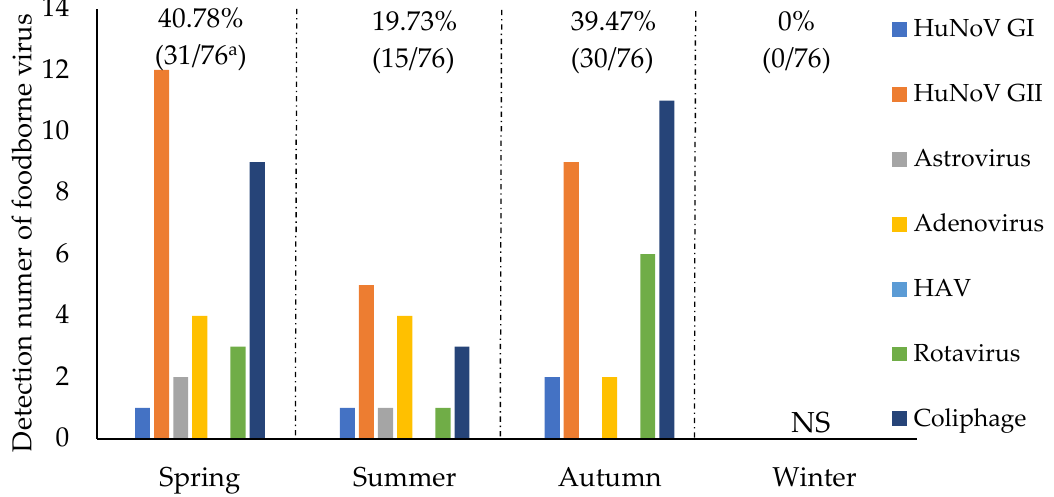
Figure 3. Seasonal prevalence of viruses and male-specific coliphages from May 2017 to November 2018; a numerator represents a number of detected viruses and male-specific coliphages; denominator represents a number of all viruses and male-specific coliphages. Spring (March–May); summer (June–August); autumn (September–November); winter (December–February). HuNoV GII was frequently detected during spring (46.15%, 12 / 26) and autumn (34.61%, 9 / 26) in contrast to summer (19.24%, 5 / 26). AdenoV was detected twice during autumn and four times each during spring and summer. RotaV was frequently detected during autumn (60%, 6 / 10) in contrast to